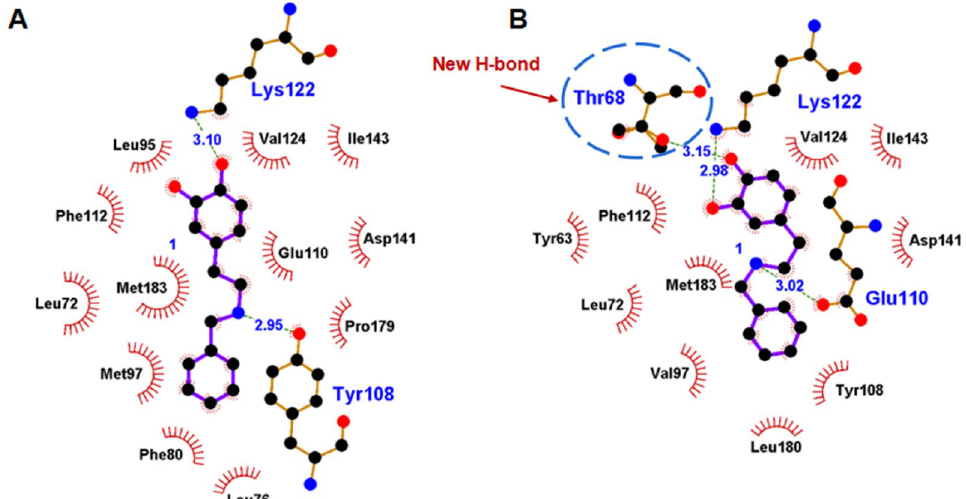
Fig. 9 Analysis of interactions around the substrate pocket of WT Tf NCS and its mutant L68T/M97V using Ligplus. A Hydrogen bonds and hydrophobic interactions between substrates and residues in the binding pocket of WT Tf NCS. B Hydrogen bonds and hydrophobic interactions between substrates and residues in the binding pocket of mutant